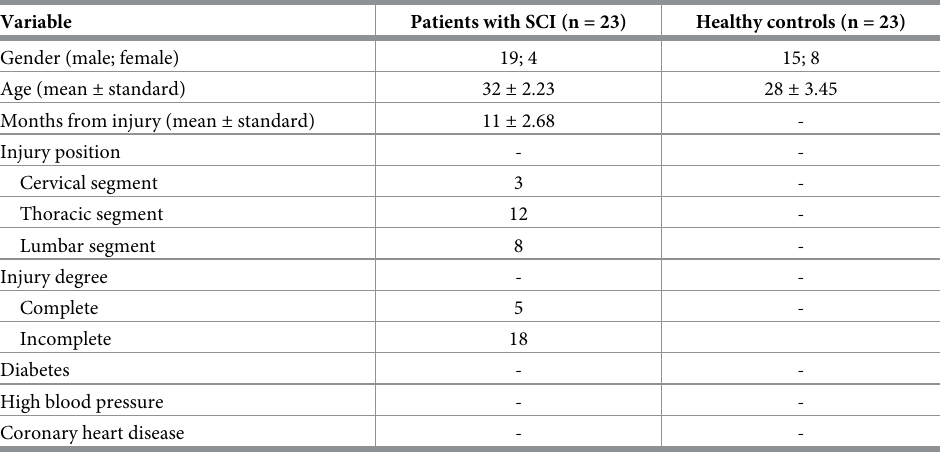
Table 1. Characteristics of patients with SCI and healthy controls. Variable Patients with SCI (n = 23) Healthy controls (n = 23) Gender (male; female)